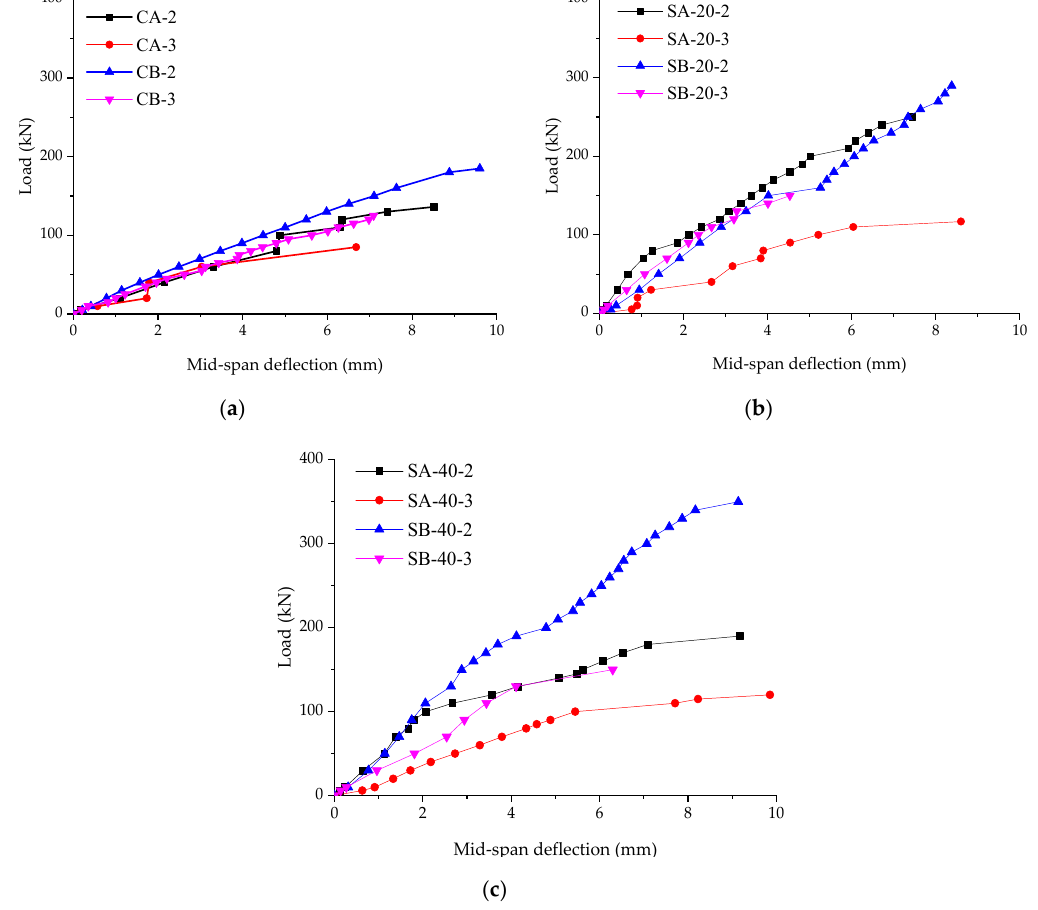
Figure 4. Load and mid-span deflection curves. ( a ) Control specimens; ( b ) Specimens strengthened with 20 mm ECC layers; ( c ) Specimens strengthened with 40 mm ECC